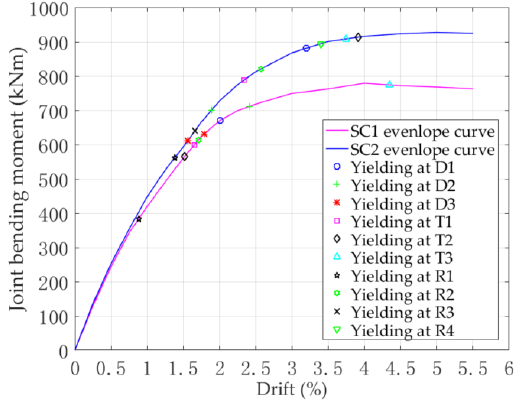
Figure 11. Load–drift envelope curves and the yielding points.